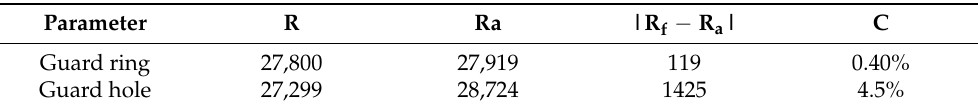
Figure 3. ( a ) Response grayscale of the detector with a guard hole; ( b ) Response grayscale of the detector with a guard ring. Table 1. The average response gray value.